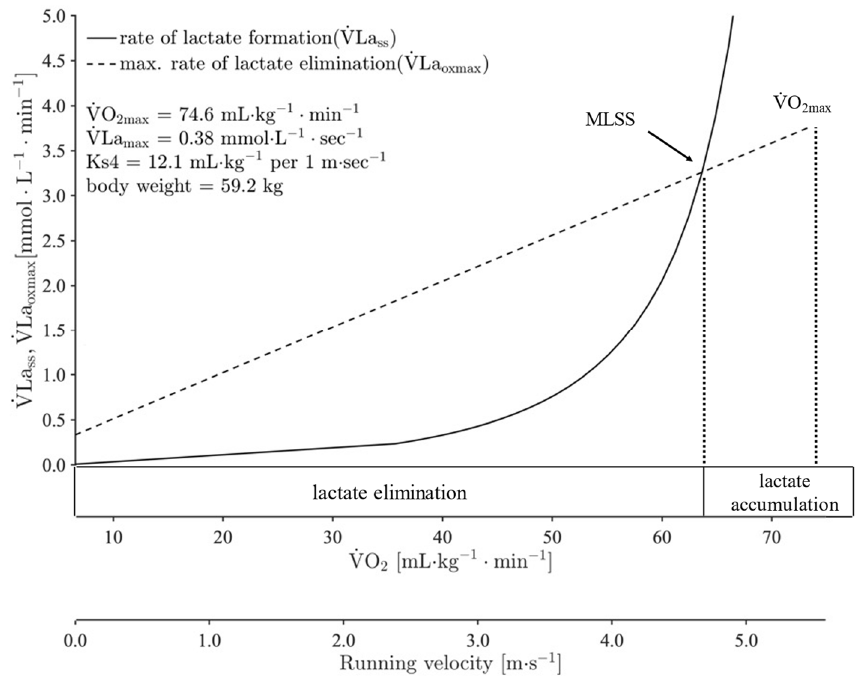
Figure 1. An exemplary description of the mathematical model for metabolic simulation, presenting the gross lactate formation (VLa ss ) and the maximal lactate elimination rate (VLa oxmax ) depending on exercise intensity [22]. Maximal lactate steady state (MLSS) is defined as the exercise intensity at which the lactate formation is exactly equal to elimination. VO 2max = maximal oxygen uptake; VLa max = maximal lactate production rate; Ks 4 = individual constant value of the relationship between oxygen demand and running velocity.